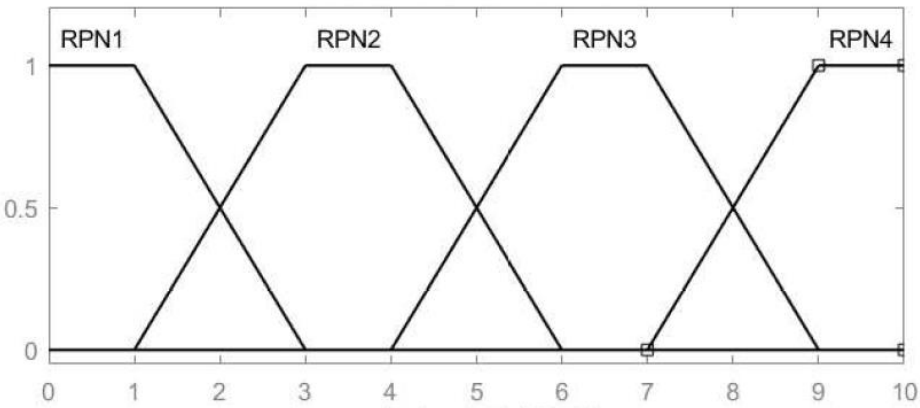
Figure 9. Membership function of detection .